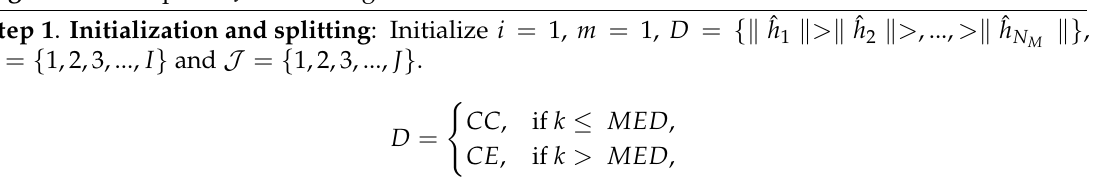
Algorithm 1 Proposed JUPDPA